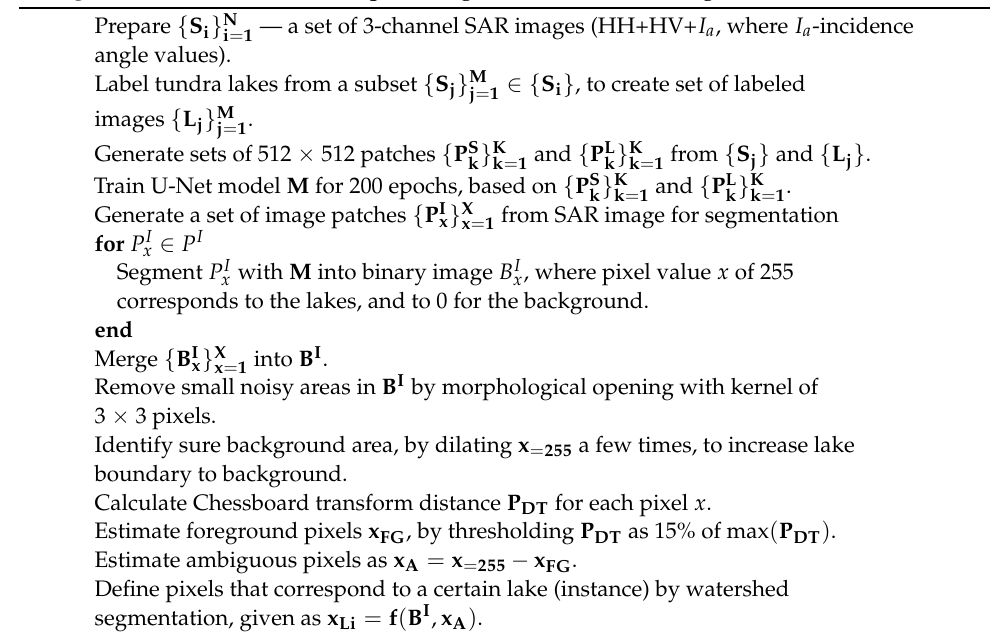
Algorithm 1: Tundra lake shapes recognition from SAR